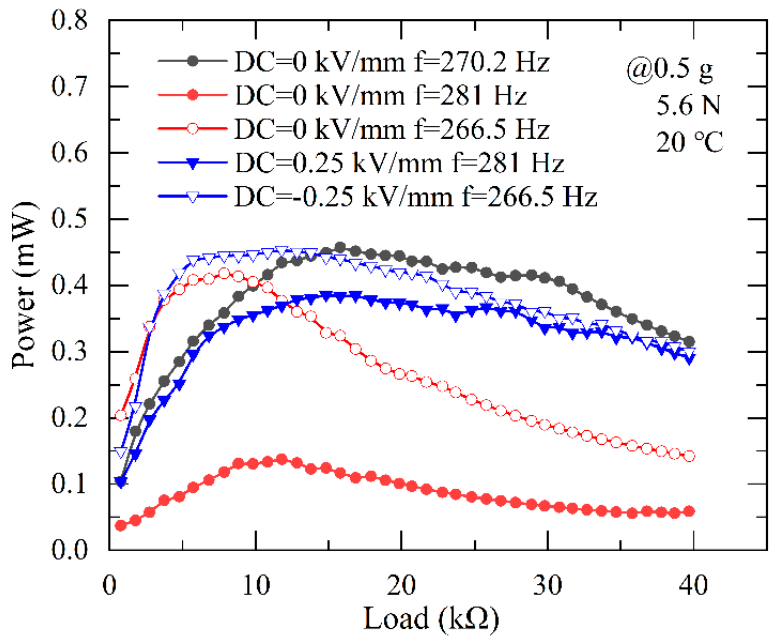
Figure 5. The output power tuning performance of the PEH under different DC electric fields.